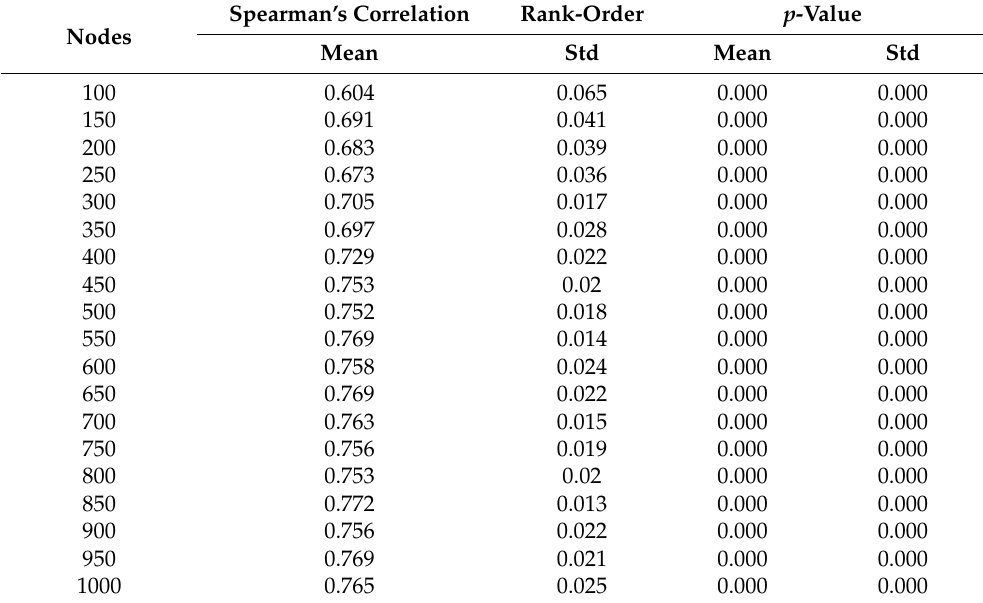
Table 6. Comparison between APABI centrality and corner centrality. For each set of networks (row), the number of nodes, the Spearman’s Correlation Rank mean value, and the standard deviation across the set are shown. Additionally, the mean values of the p -value and standard deviations are presented. Every set had 30 networks with the number of nodes given in the first column. The nodes were chosen from the MN_AK multiplex network.